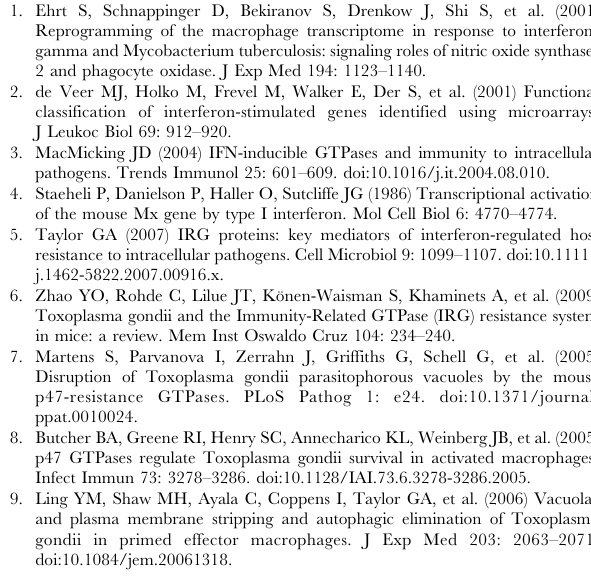
Figure S5 mGBP2/5 co-localize with mGBP1 at the PV of type II T. gondii upon IFN- c pre-stimulation. Pictures were taken with a spinning disk confocal microscope. MEFs that